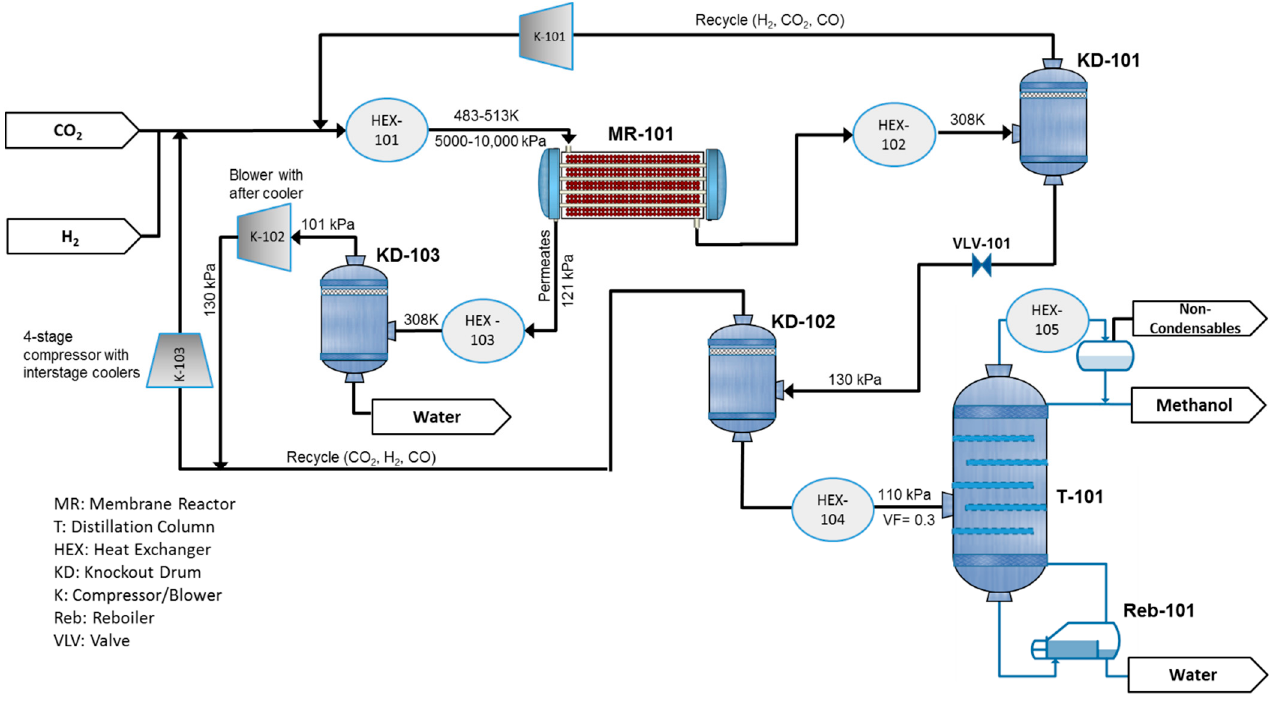
Figure 2. Process flow diagram for a methanol production plant aided with a water-selective membrane reactor (MR).